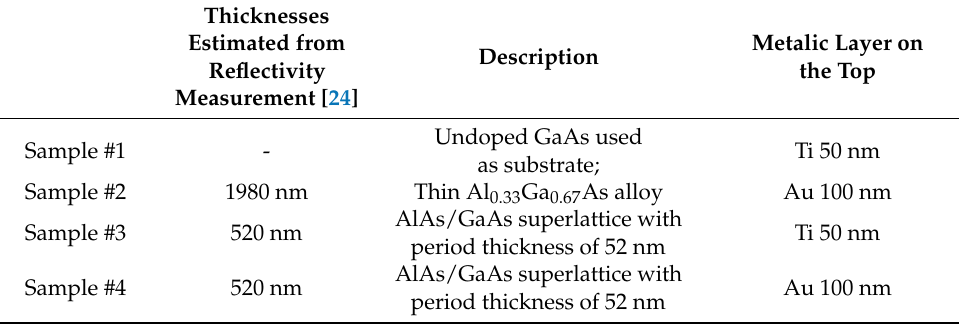
Table 1. Summary of the sample properties.